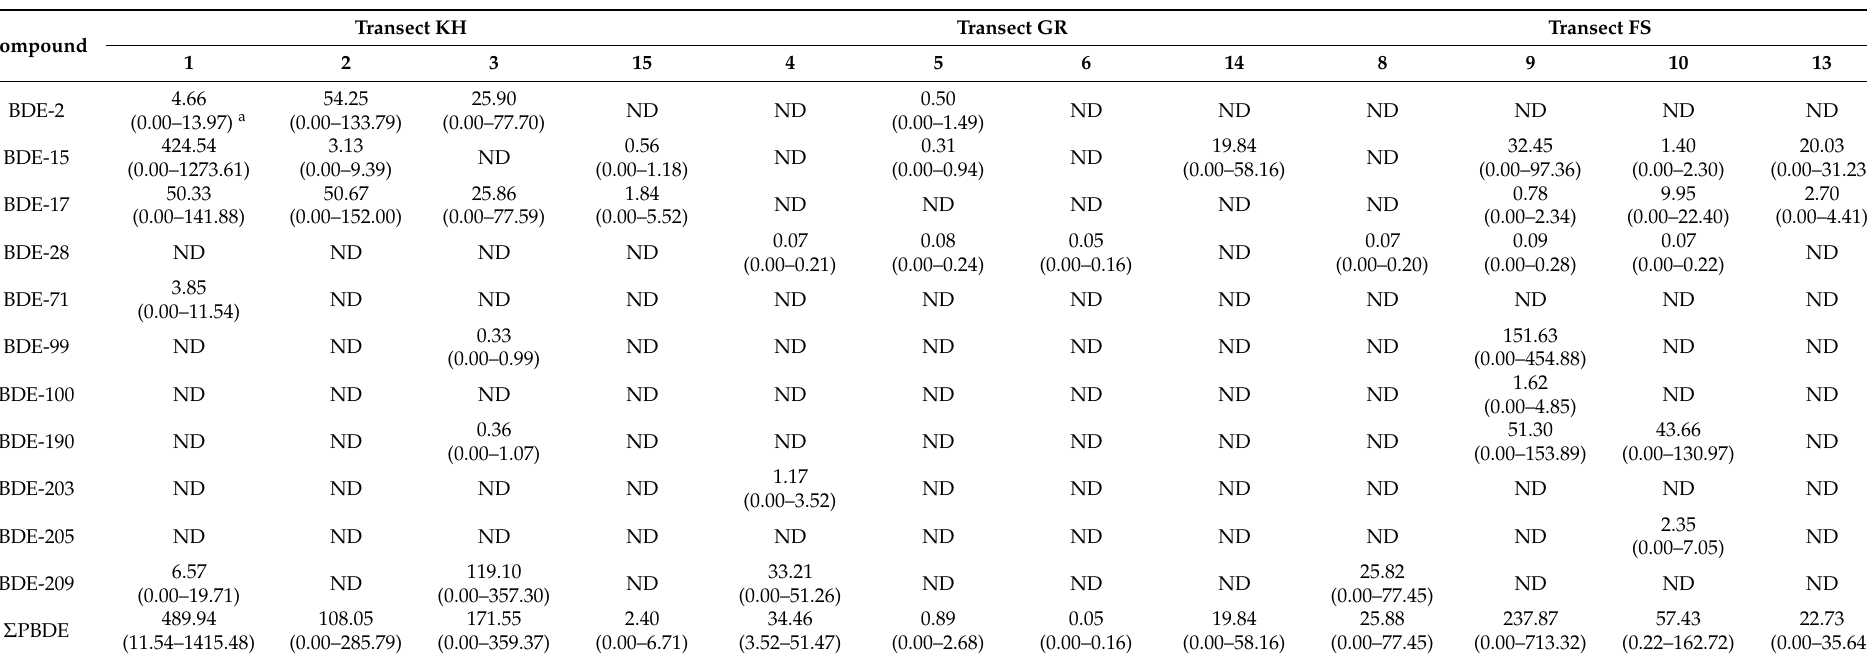
Table 3. PBDE concentrations in zooplankton (ng g − 1 dw) samples collected at the different sampling stations during the study period. KH: Kaohsiung